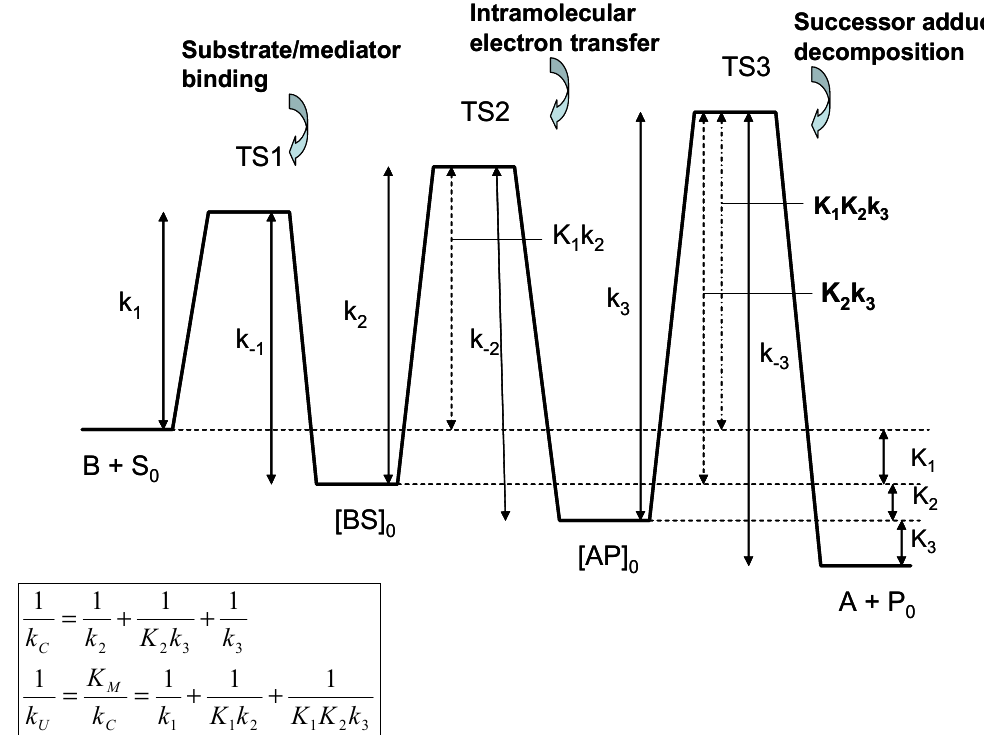
Figure 9. Energy profiles for adduct formation